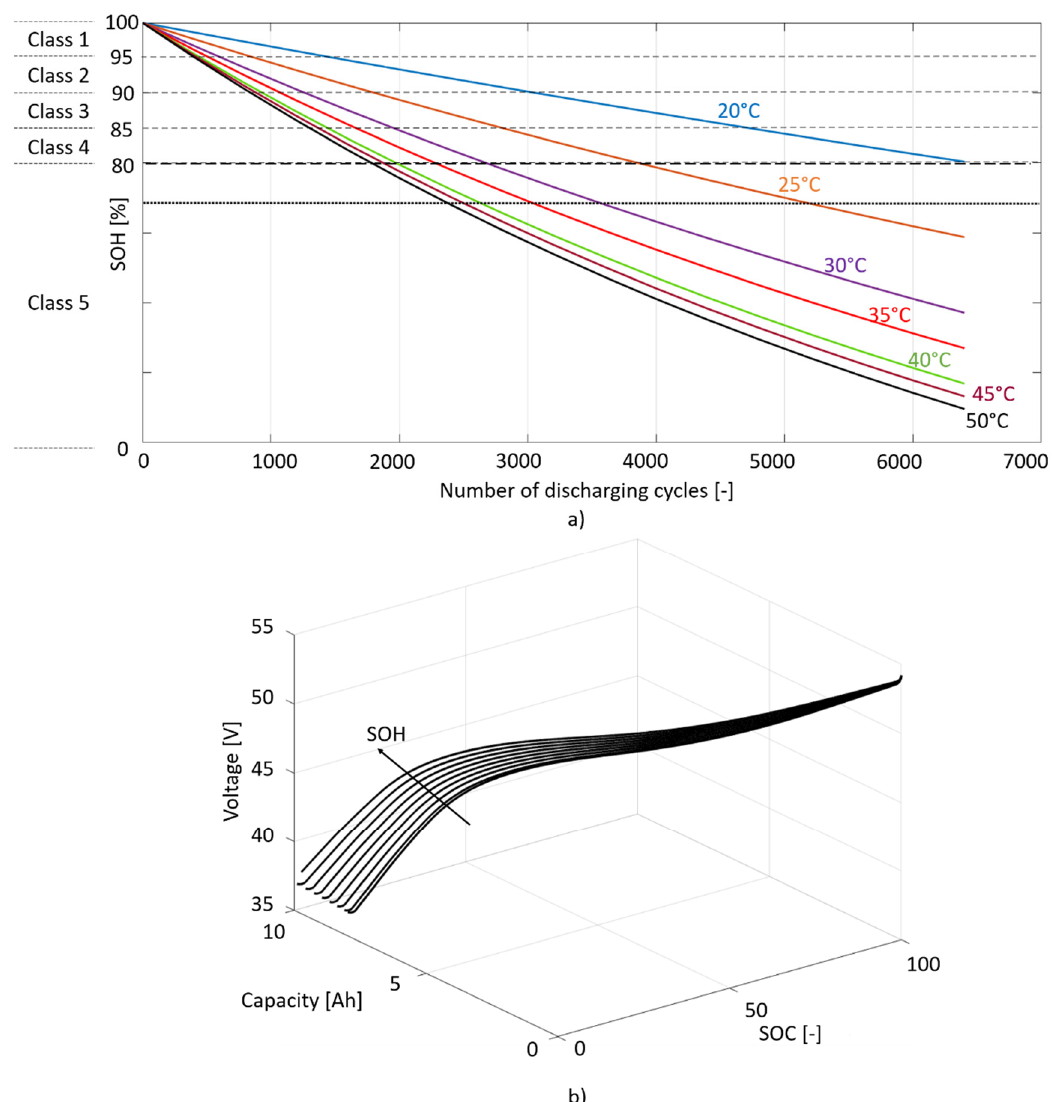
Figure 4. Battery experimental characterization for the SOH estimation. ( a ) SOH as a function of the number of discharging cycles and of the temperature. ( b ) Behavior of the SOH as a function of the voltage, capacity, and SOC. The temperature in this case is set equal to 25 °C.